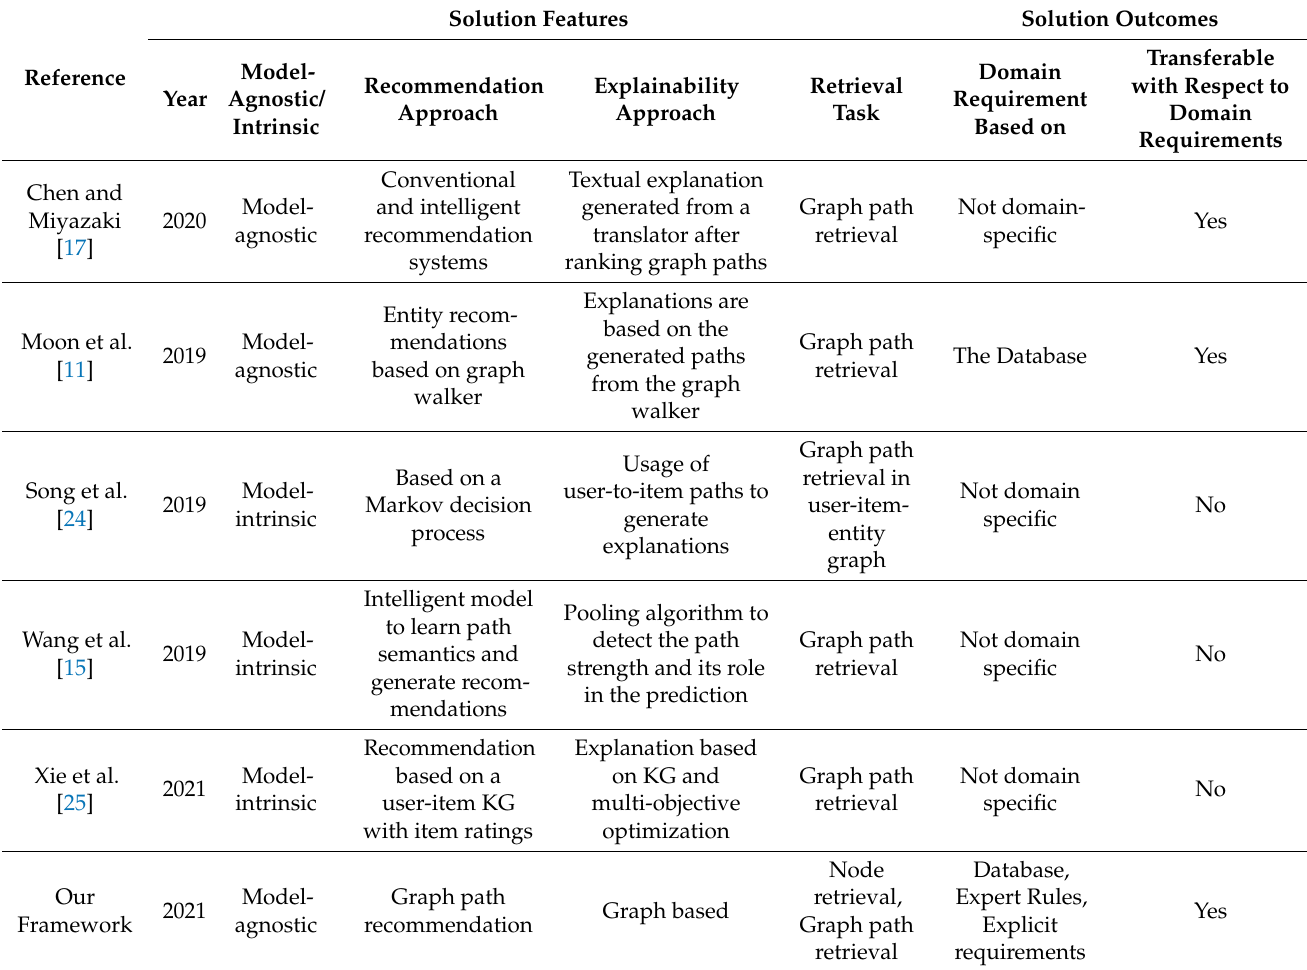
Table 1. Comparison between different explainability